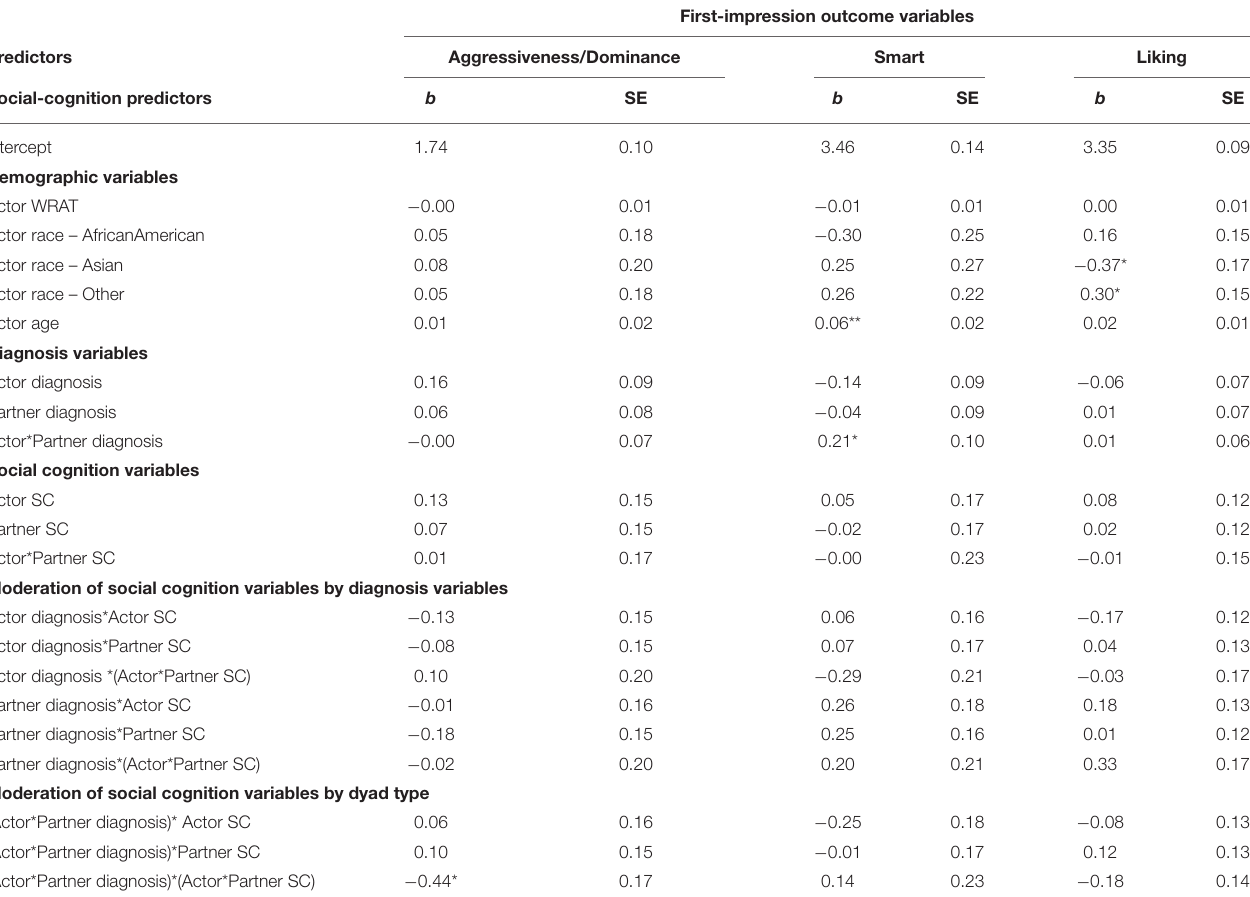
First-impression outcome